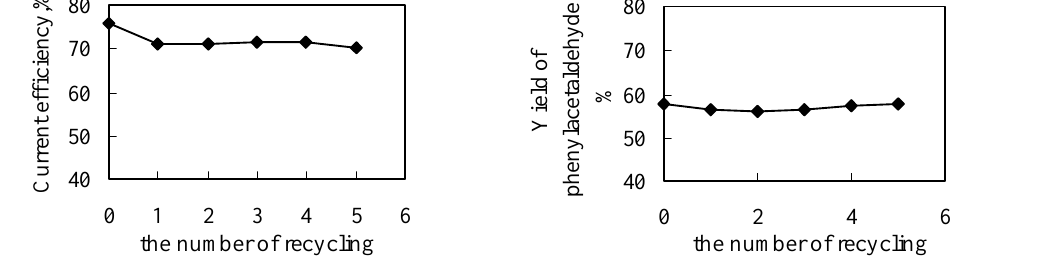
FIGURE 2 . The effect of the recycling number on current FIGURE 3 . The effect of the recycling number on yield of efficiency.